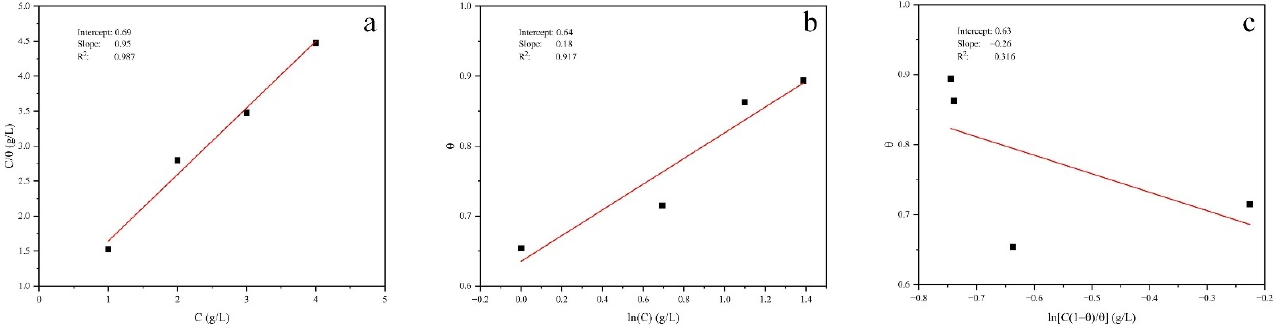
Figure 4. Fitting results of three adsorption theories: ( a ) Langmuir, ( b ) Temkin and ( c ) Frumkin.